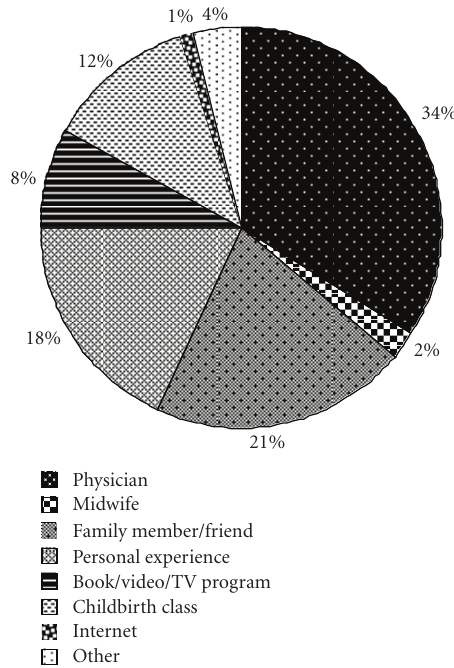
Figure 2: The main sources of information use by women surveyed ( n = 301) to learn about epidurals prior to going into